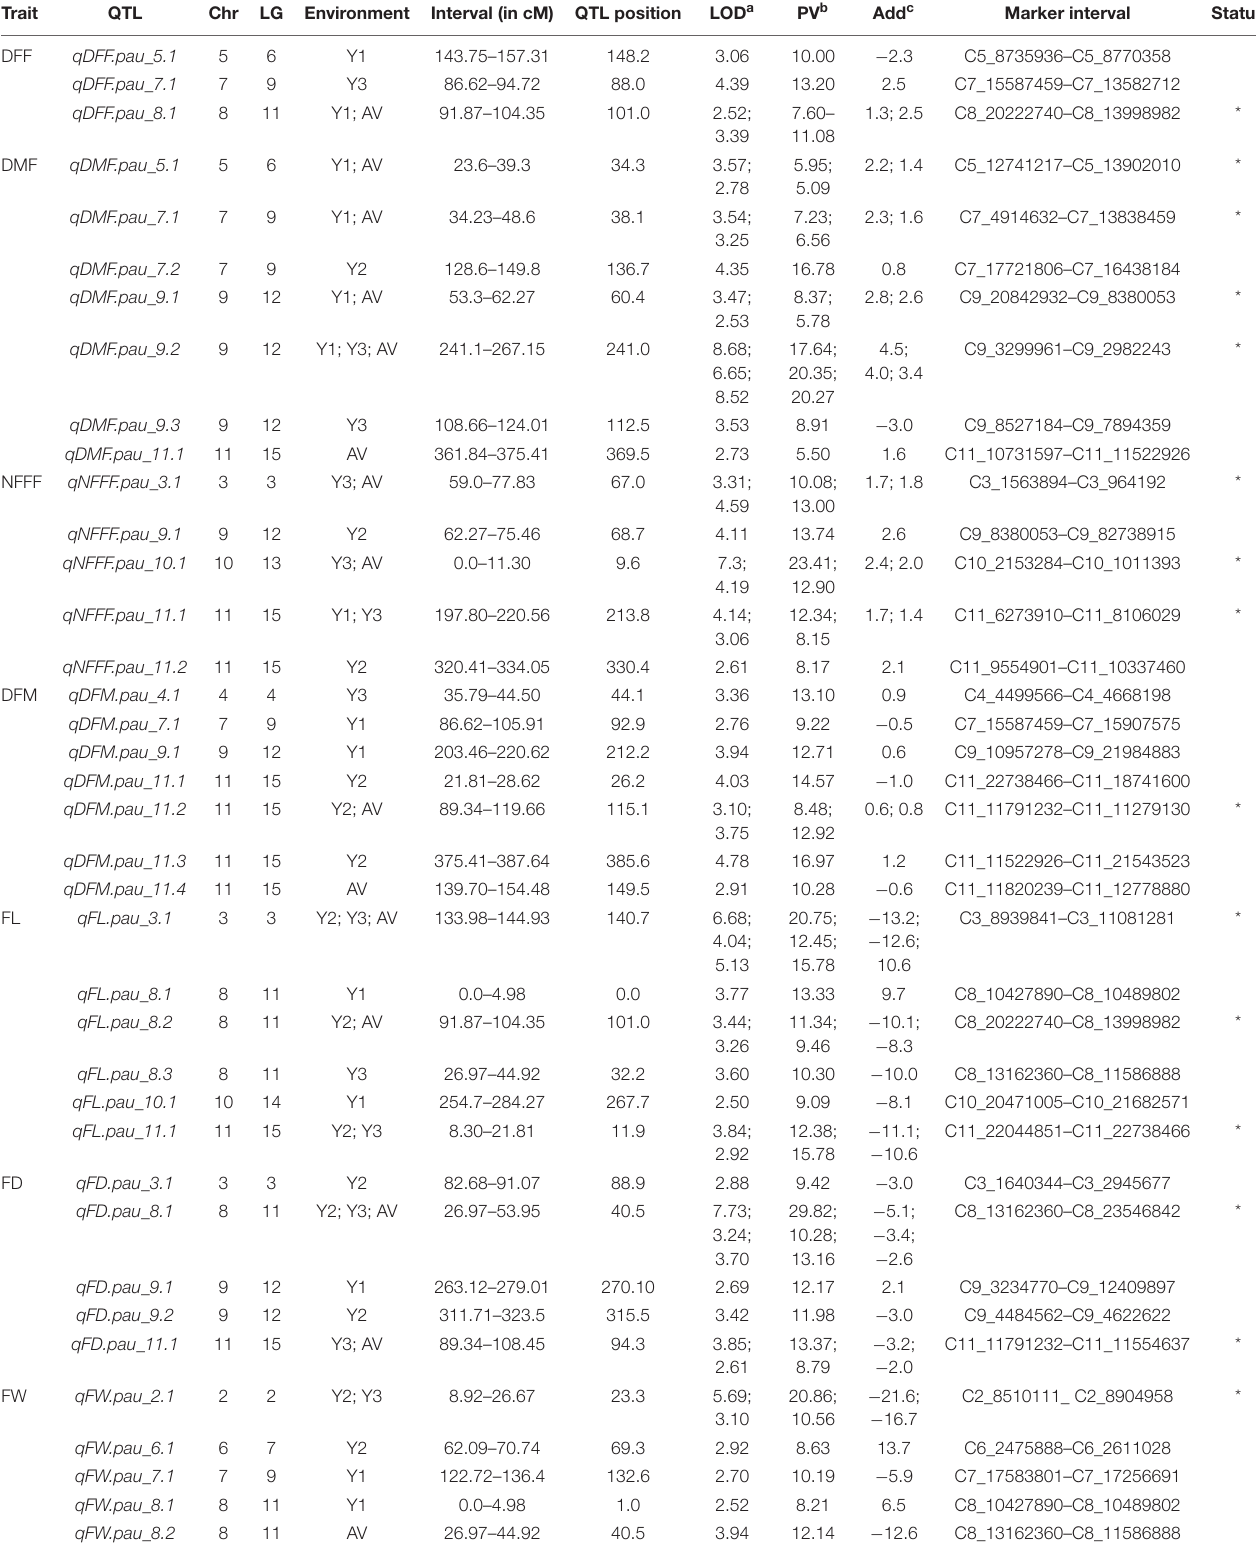
TABLE 3 | Summary of the quantitative trait loci (QTLs) detected in the mapping population derived from the cross of bitter gourd cv. Punjab-14 and PAUBG-6 based on SNP based linkage map consisting of 3,144 markers.